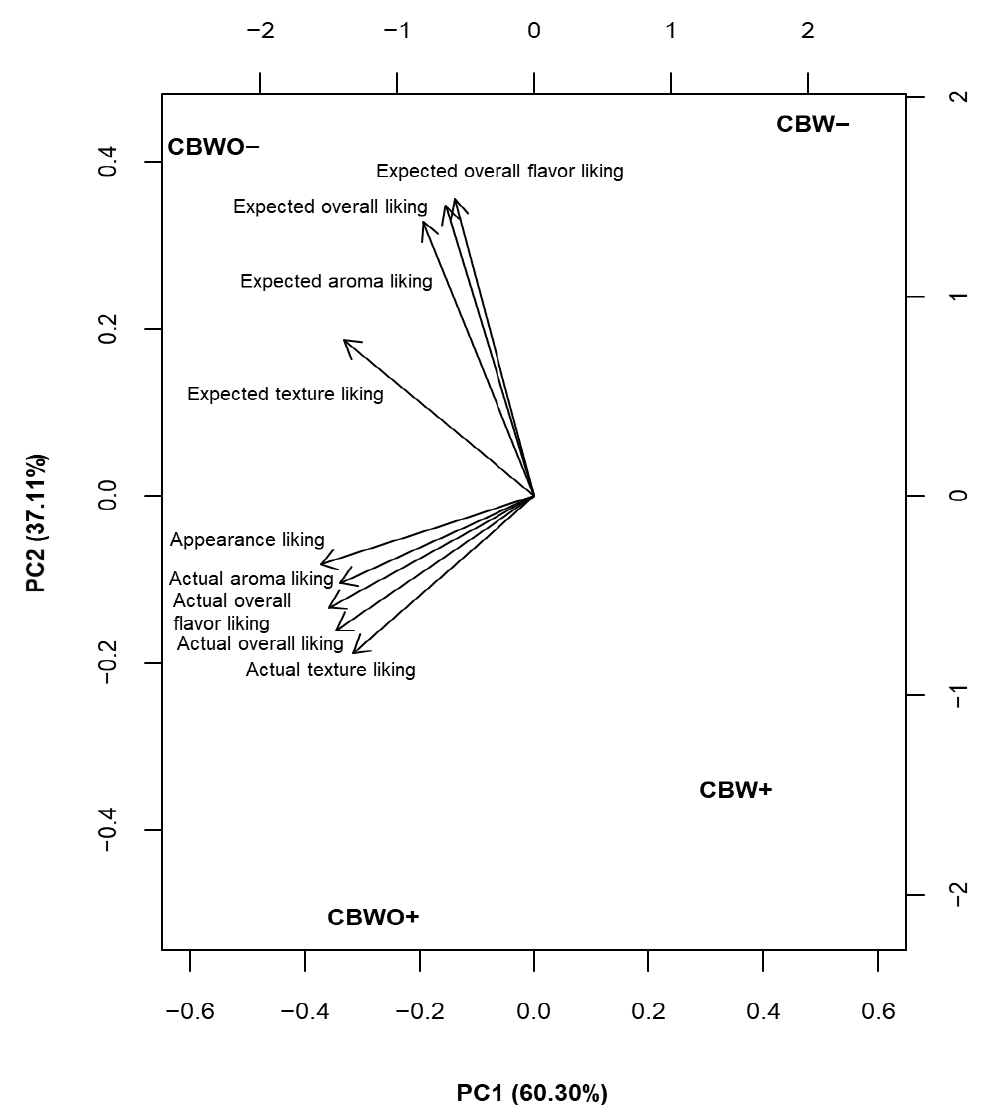
Figure 3. Principal component analysis (PCA) biplot visualizing expected and actual sensory liking and treatments † . † Treatments are described in Figure 1.